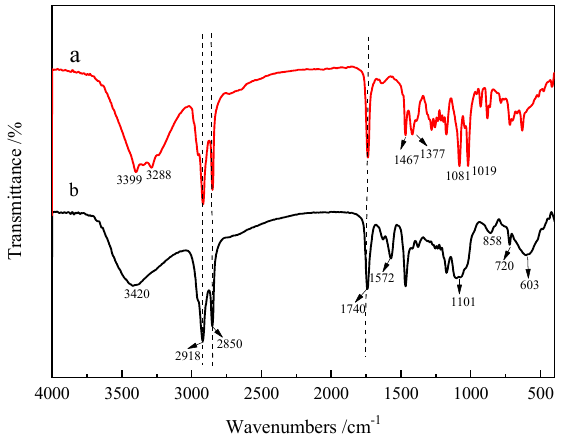
Figure 1. FTIR spectra of (a) MSE and (b) MSE-Al.